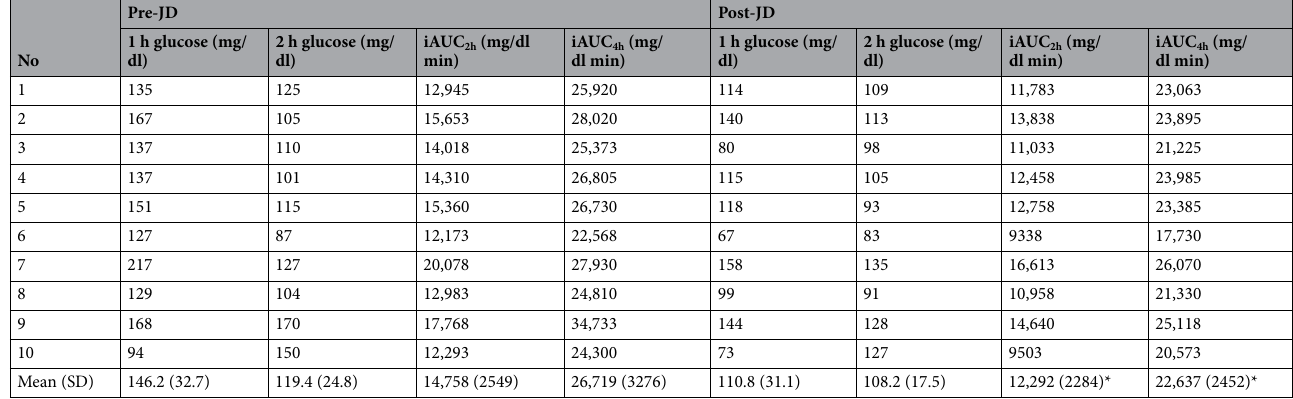
Table 2. Interstitial glucose values at 1 and 2 h during the oral glucose tolerance test, and area under the curve (iAUC 2h and iAUC 4h ) before (Pre-JD) and after 7 days of passive simulated jogging (Post-JD). Peak one and two hour interstitial glucose values [1 h, 2 h Glucose (mg/dl)] and integrated 2 h and 4 h Areas Under the Curve (iAUC 2h, iAUC 4h ) during the oral glucose tolerance test, before (Pre-JD) and after 7 days of passive simulated jogging (Post-JD) for each study subject (No). Mean and standard deviation (SD) for each column. *p < 0.03 (pre vs post